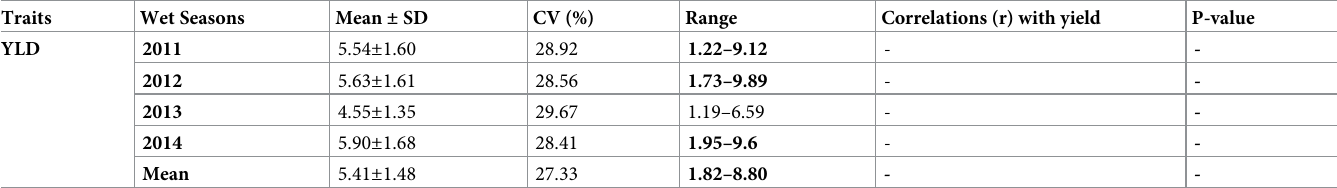
Some genotypes produced appreciably higher grain yield in respective seasons. Among them, N-129 produced highest grain yield in all the four seasons (9.12 t/ha in 2011; 9.89 t/ha in 2012; 6.59 t/ha in 2013 (productivity affected due to Cyclonic Storm Phailin) and 9.60 t/ha in 2014). It was followed by R-261 (8.01 t/ha in 2011), N-370 (8.78 t/ha in 2012), N-8 (6.34 t/ha in 2013) and N-8 (8.86 t/ha in 2014), respectively. The mean of grain yield in four seasons varied from 1.82 to 8.8 t/ha. Twenty NPTs performed very well consistently in all the four seasons (S2 Table). The average grain yield of four seasons of these 20 genotypes varied from 5.45 to 8.8 t/ ha, while popular varieties such as IR64 and MTU1010 produced the maximum yield of 4.80 to 4.99 t/ha (Fig 1A, 1B and 1C, S2 Table).